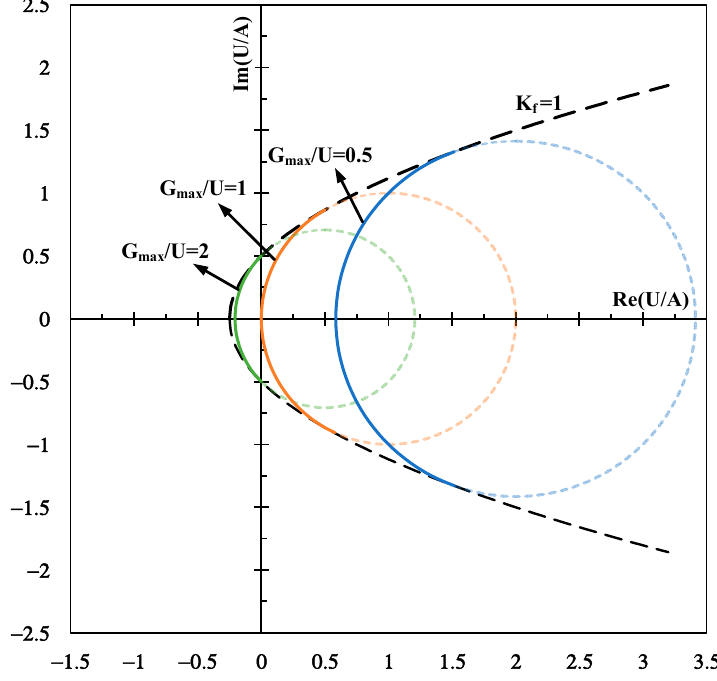
Figure 2. G max circles and the stability boundary with respect to U / A .